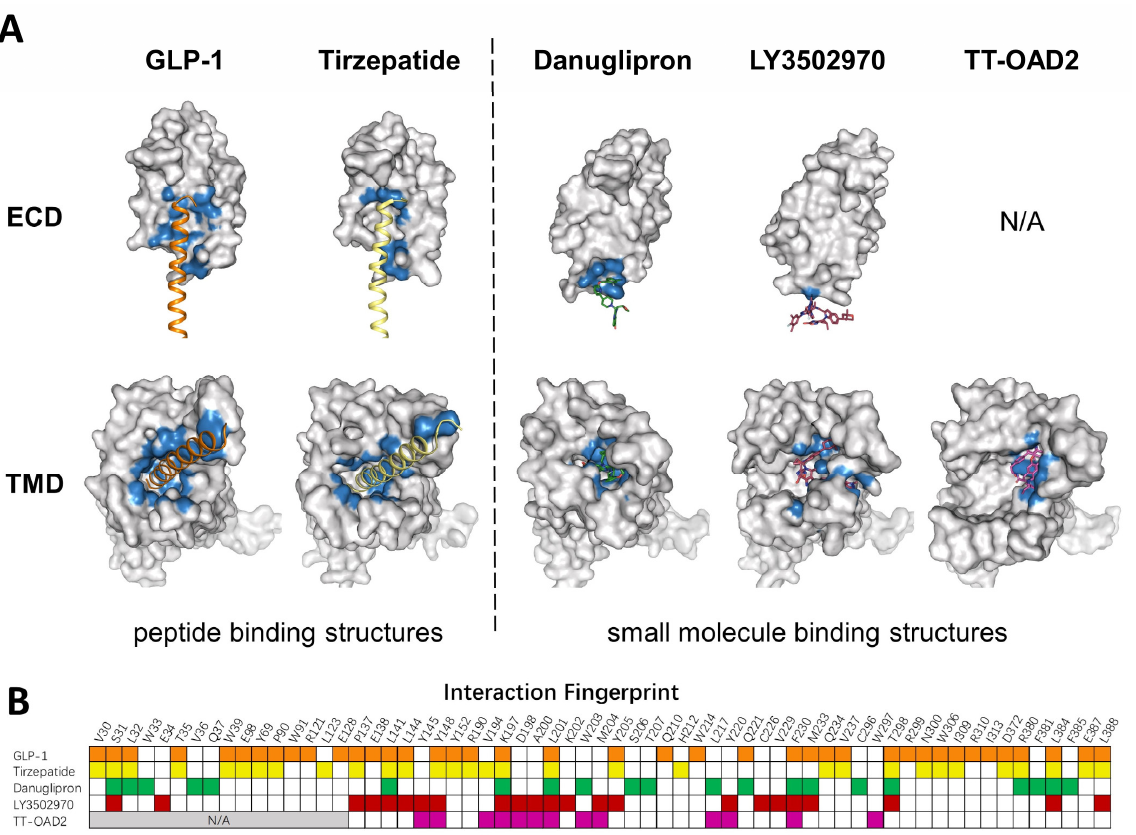
Figure 3. Comparison of peptide and small molecule binding pockets. ( A ) Structures of GLP1R in complex with GLP1 (PDB: 6X18), tirzepatide (PDB: 7RGP), danuglipron (PDB: 6X1A), LY3502970 (PDB: 7E14), and TT-OAD2 (PDB: 6ORV) are shown in the separated ECD and TMD. GLP-1R is shown as a gray surface model. Residues within 4 Å of the corresponding ligand are colored in blue. ( B ) Specific residues that interact with corresponding ligands in a fingerprint array. Ligands in (A) and their interaction fingerprints in (B) appear as follows: GLP-1 (orange), tirzepatide (yellow), danuglipron (green), LY3502970 (red), TT-OAD2 (magenta). N/A, not applicable. ECD was not resolved in TT-OAD2 binding structure.